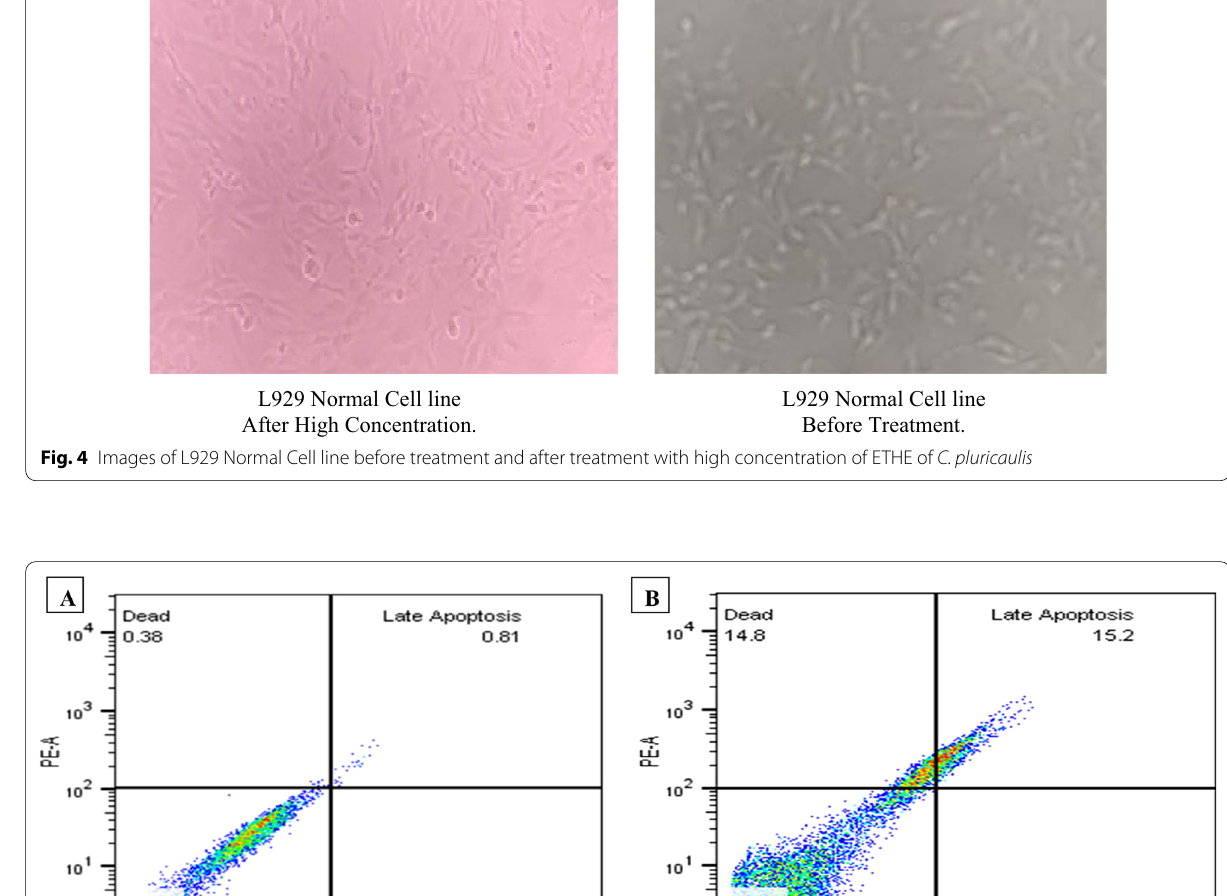
/PI ) early apoptosis in lower right quadrant/ (Q3), while (Annexin + −